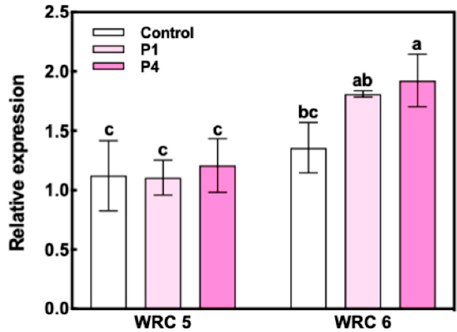
Figure 4. Relative gene expression of INO1 at 10 DAF in WRC 5 and WRC 6. White and pink indicate the control and P treatment, respectively. Each value represents the mean ± SD of three replicates. Different letters indicate statistical differences (Tukey’s HSD test, p < 0.05).